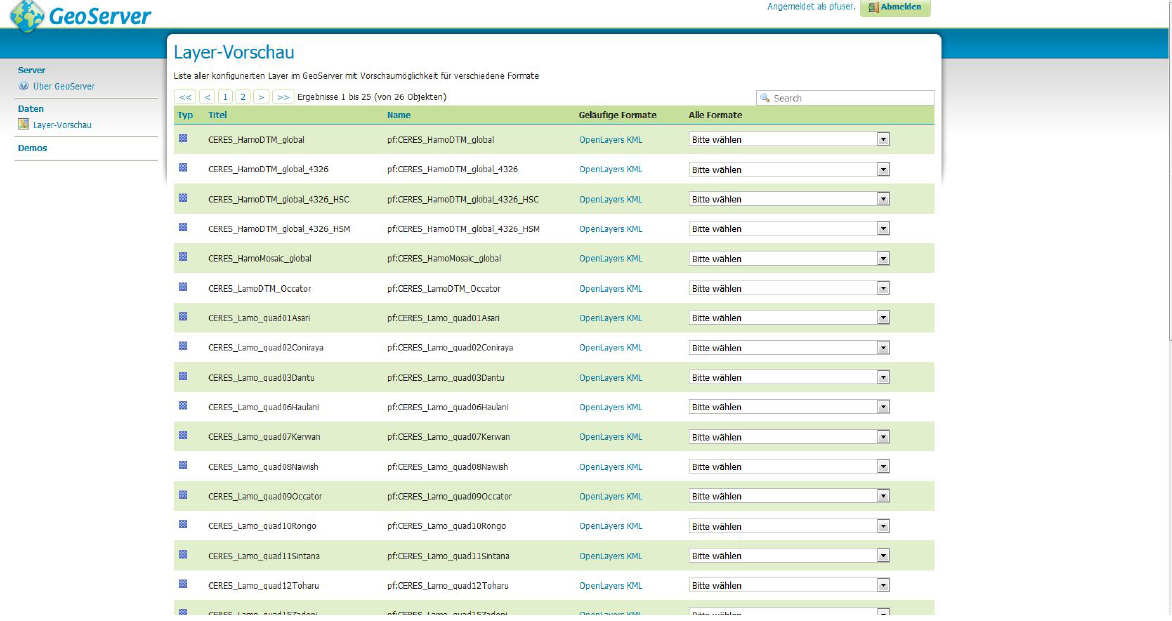
Figure 5. Screenshot of the prototype: spatial planetary sample data from Ceres stored in the GeoServer of the EOC